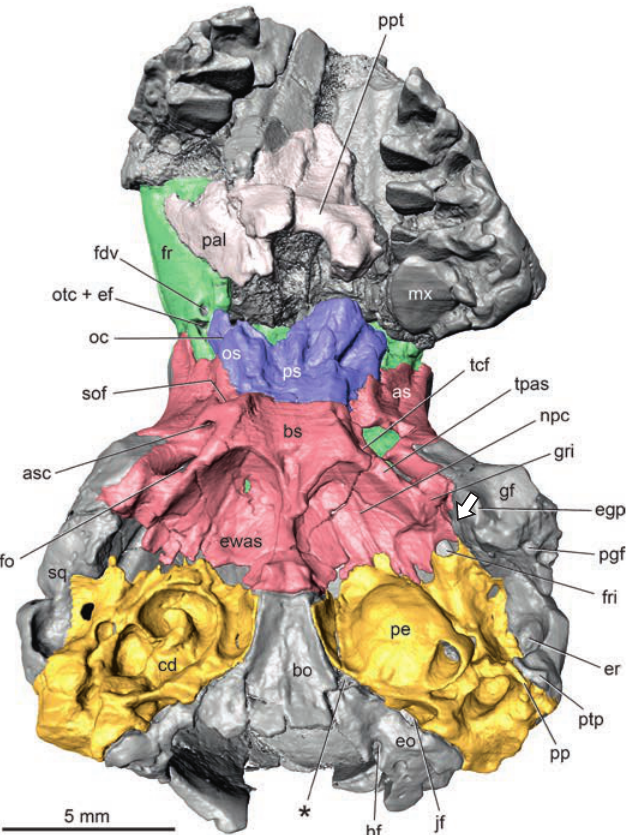
Fig. 1. Palaeoryctid mammal Eoryctes melanus Thewissen and Gingerich, 1989, UM 68074 (UM locality SC-133, Clarks Fork Basin, Wyoming, USA; early Wasatchian Land-Mammal Age, early Eocene), isosurface of cranium rendered from CT scans in ventral view. Petrosals in gold; basi- and alisphenoids in red; pre- and orbitosphenoids in blue; frontals in green. Asterisk marks the depression identified as the foramen for the ventral pe- trosal sinus by Thewissen and Gingerich (1989). Arrow is directed at the Glaserian fissure. Abbreviations: as, alisphenoid; asc, alisphenoid canal; bo, basioccipital; bs, basisphenoid; cd, exposed cochlear duct; egp, ento- glenoid process; eo, exoccipital; er, epitympanic recess; ewas, epitympanic wing of alisphenoid; fdv, frontal diploic vein foramen; fo, foramen ovale; fr, frontal; fri, foramen for ramus inferior; gf, glenoid fossa; gri, groove for ramus inferior; hf, hypoglossal foramen; jf, jugular foramen; mx, maxilla; npc, groove for nerve of pterygoid canal; oc, optic canal; os, orbitosphe- noid; otc + ef, anterior opening of orbitotemporal canal and ethmoidal fora- men; pal, palatine; pe, petrosal; pgf, postglenoid foramen; pp, paroccipital process; ppt, postpalatine torus; ps, presphenoid; ptp, posttympanic pro- cess of squamosal; sof, sphenorbital fissure; sq, squamosal; tcf, transverse canal foramen; tpas, tympanic process of